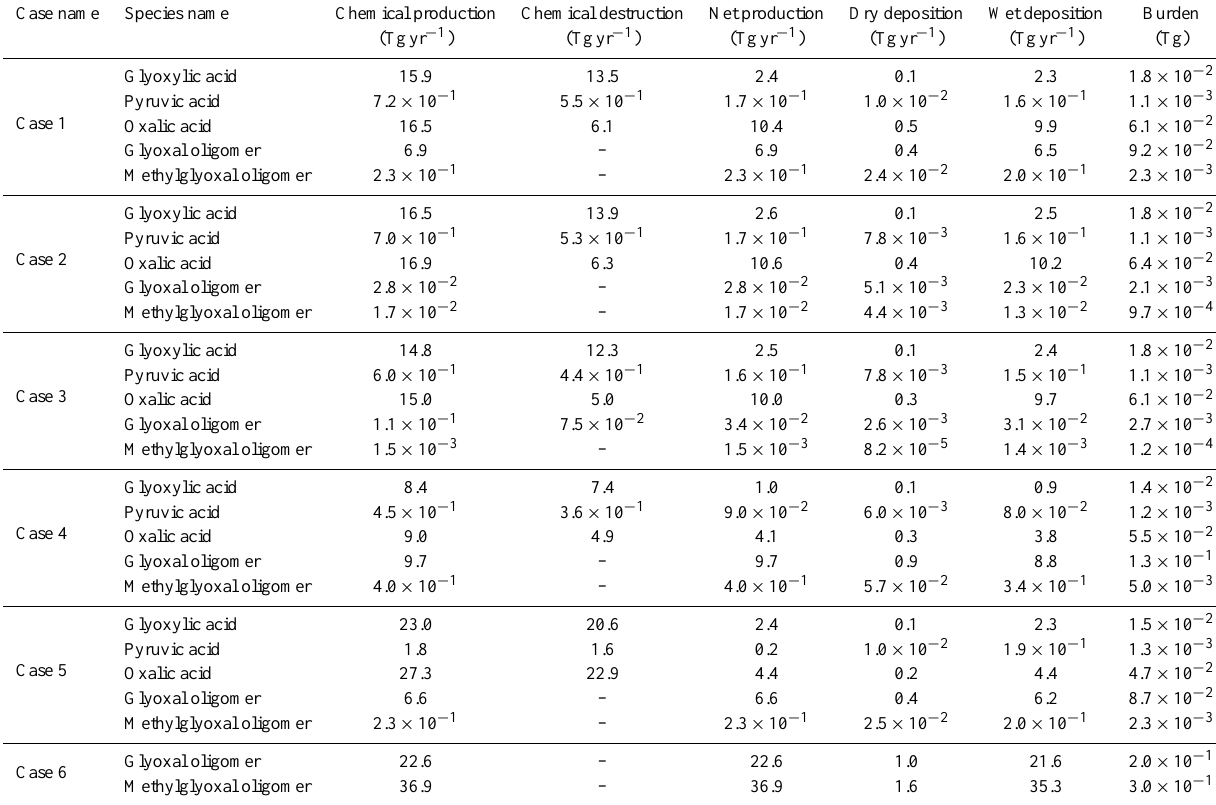
Table 2. Global aqSOA budget analyses for all